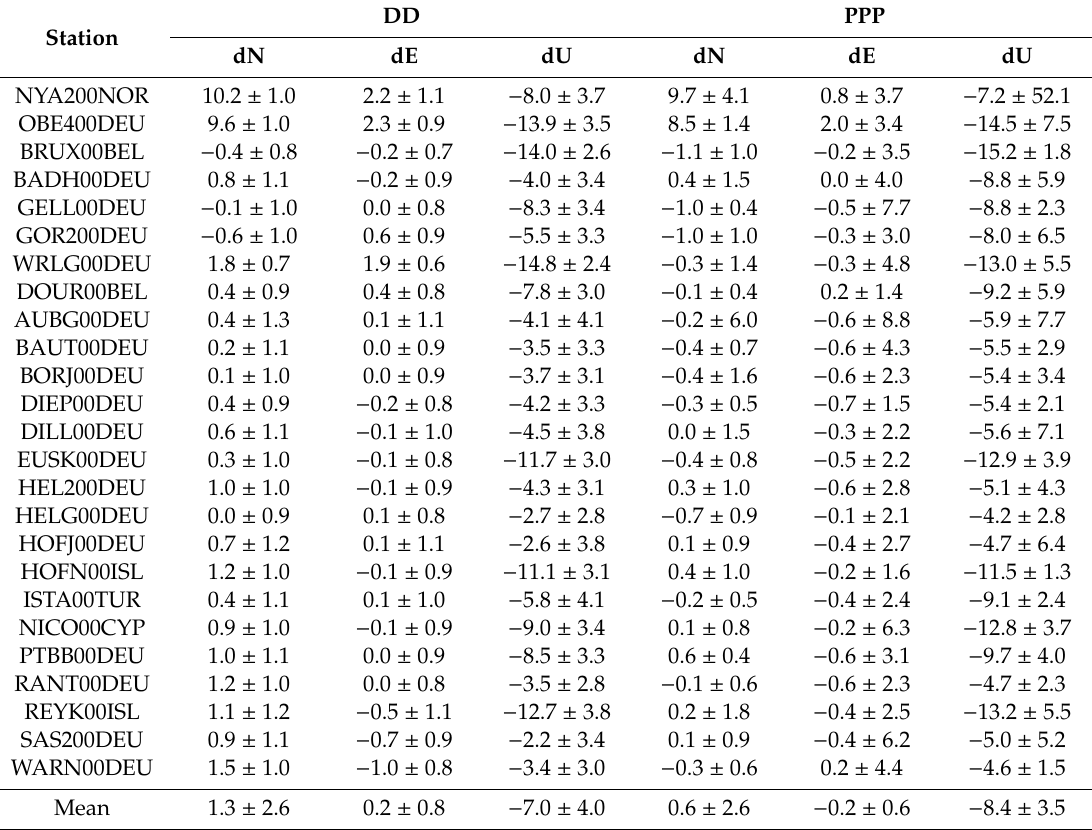
Table A1. Coordinate di ff erences between solution E1 and E2 (E2 minus E1) and their standard deviations. All values in millimeters.